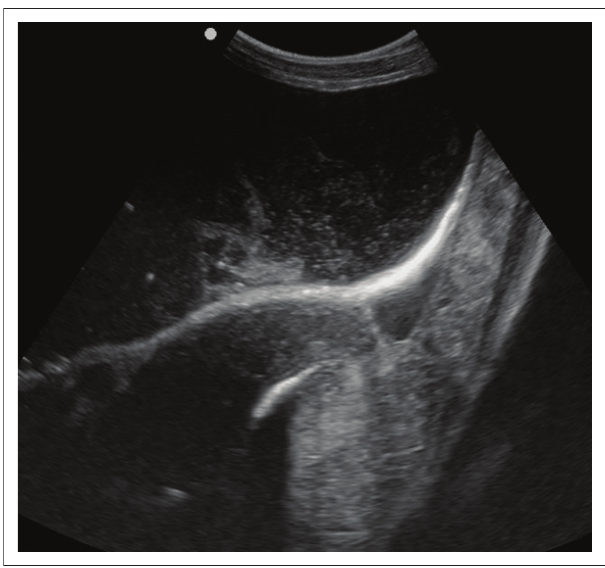
FIGURE 1: An ultrasonographic evaluation of the steenbok abdomen at presentation revealing distension of the bladder.